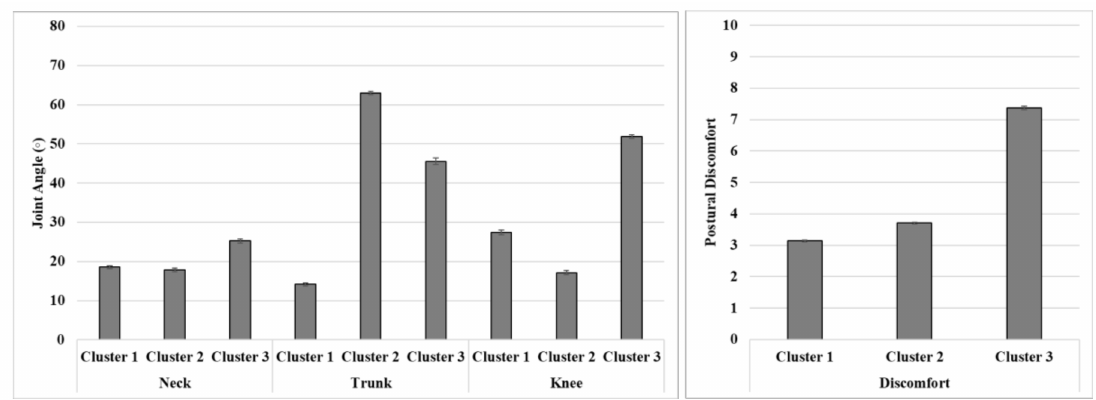
Figure 4. Means and standard errors (error bars) of the neck, trunk, and knee flexion angles, as well as postural discomfort for the three